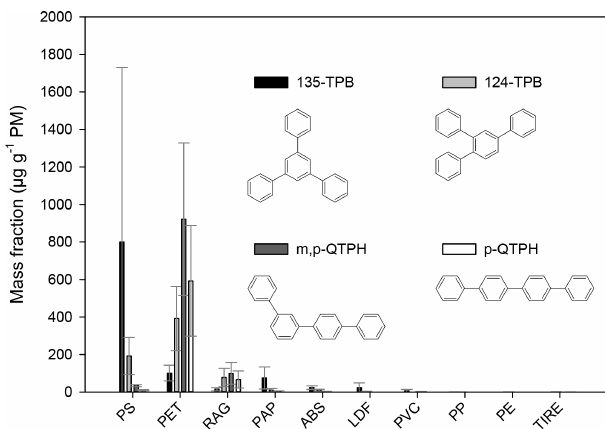
Figure 3. The mass fraction of the compounds (in units of µgg − 1 PM) emitted during the burning of styrene-containing copolymers. The error bars represent the standard deviation of the EF data obtained for a given type of waste under different burning conditions.